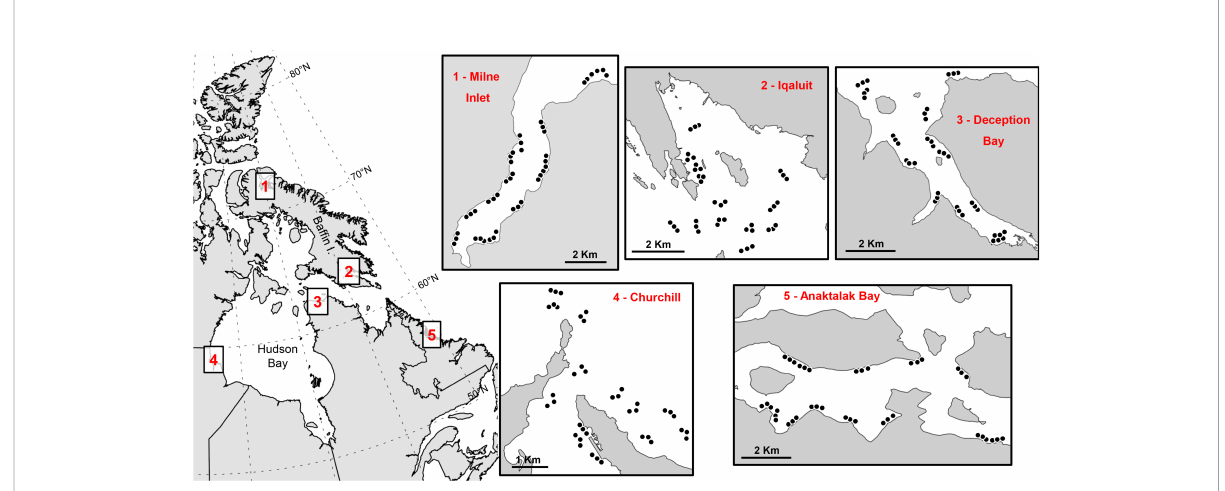
FIGURE 1 Map showing surveyed Arctic locations and the sites of each benthic trawl